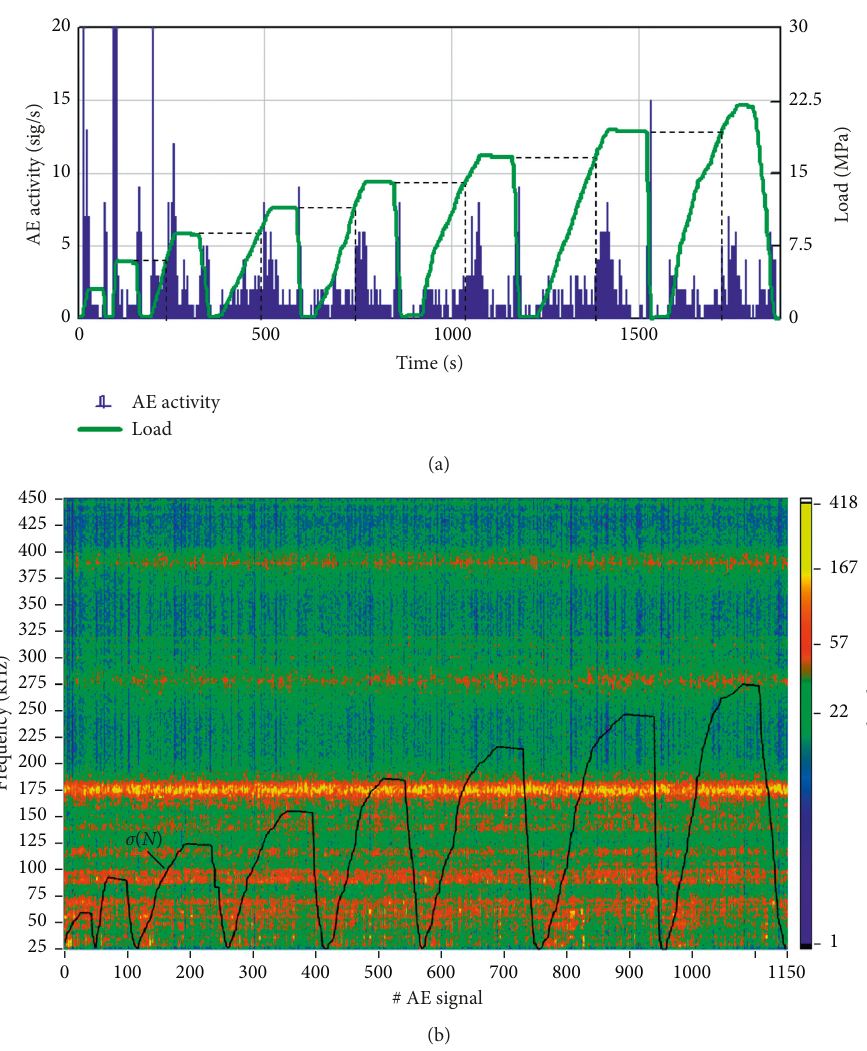
Figure 3: AE activity upon loading the sample from the first group of the “A” series (a) and an example of the obtained spectrogram with superposition of the σ ( N )